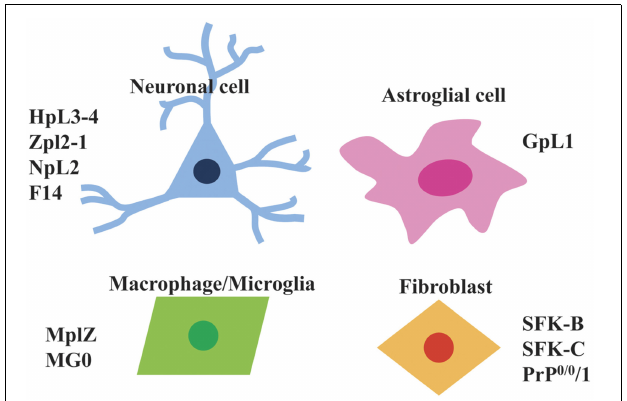
FIGURE 2 | Types of Prnp − / − cell lines that are available. Currently available Prnp − / − cell lines can be divided into four types i.e., neuronal cells (HpL3-4, Zpl2-1, NpL2, F14), astroglial cells (GpL1), macrophage/microglia (MpLZ, MG0), and fibroblasts (SFK-B, SFK-C, PrP 0 / 0